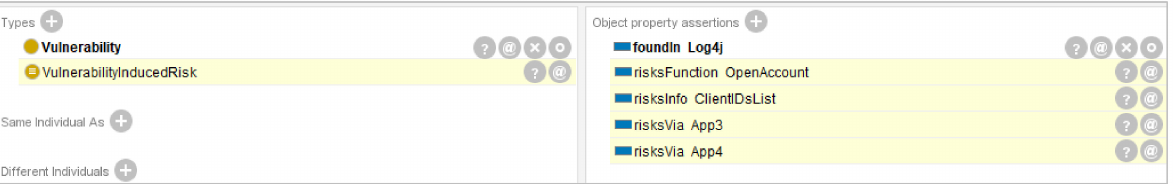
Figure 2. The Log4shell ontology-based assertions in Protege. Manually stated (explicit) assertions appear in bold font, while automatically inferred assertions appear in regular font.